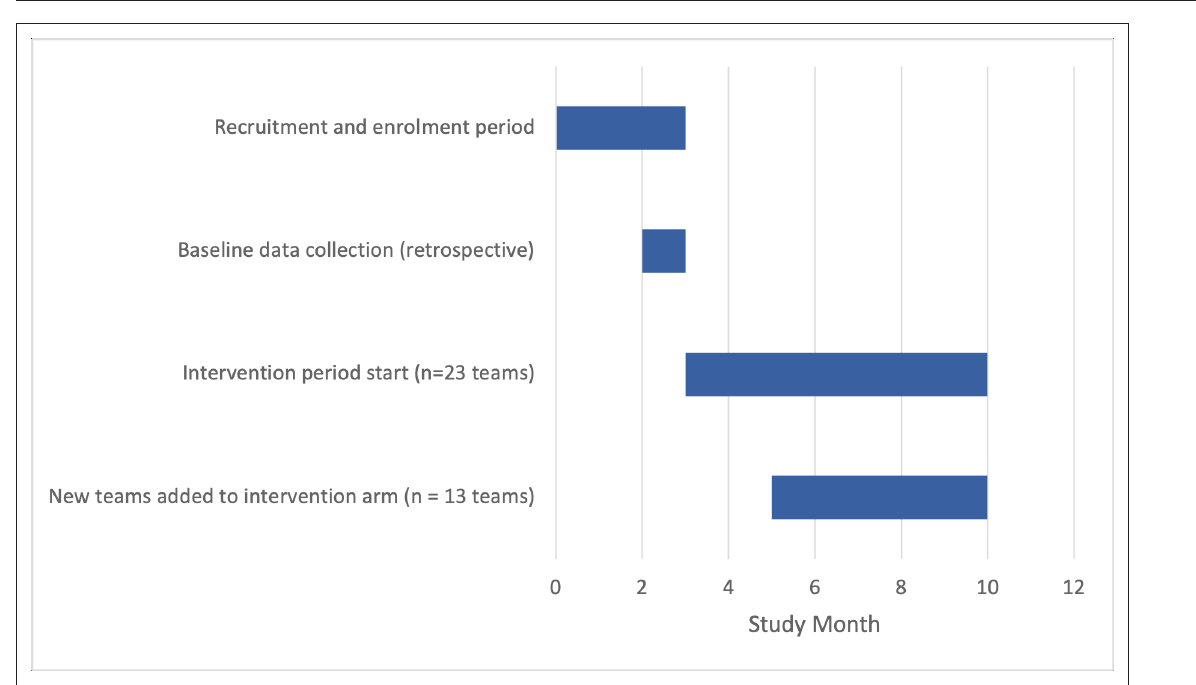
Figure 1 Team recruitment, enrolment, and intervention